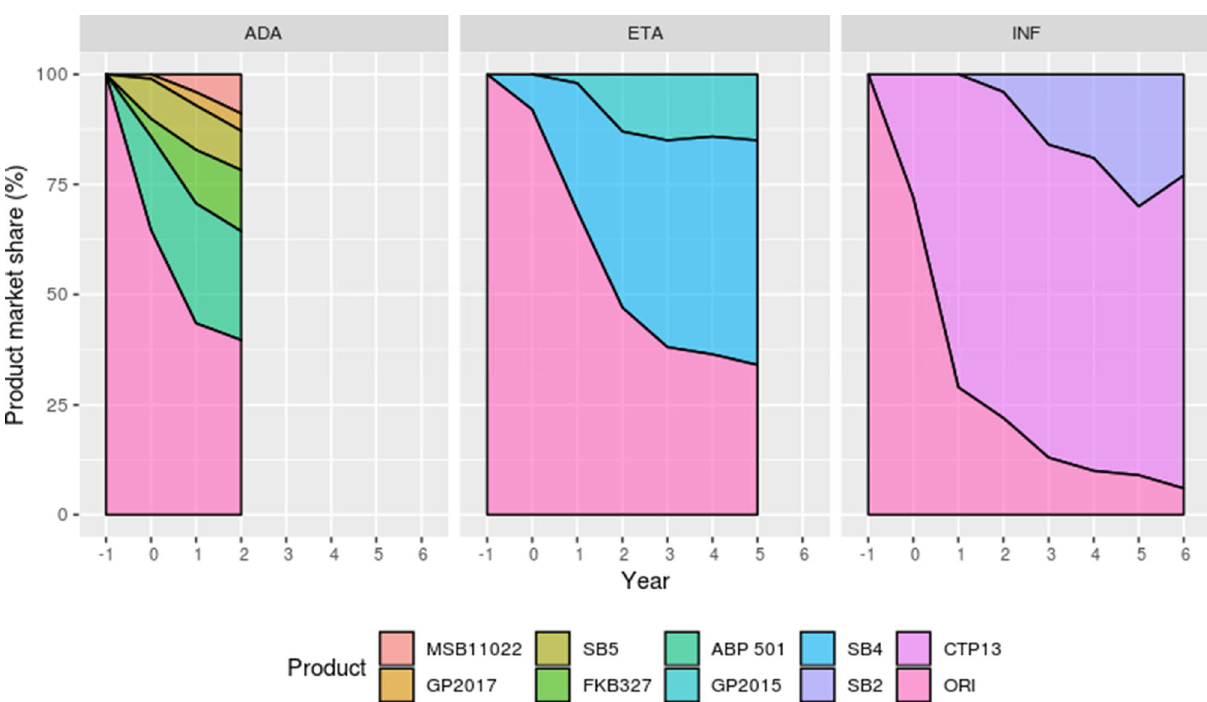
Figure 3. TNF-alpha inhibitors initiation rate by product between year − 1 and 6 (if applicable) after first biosimilar entry for each molecule. ADA, ETA and INF refer to adalimumab, etanercept and infliximab respectively. ORI refers to originator